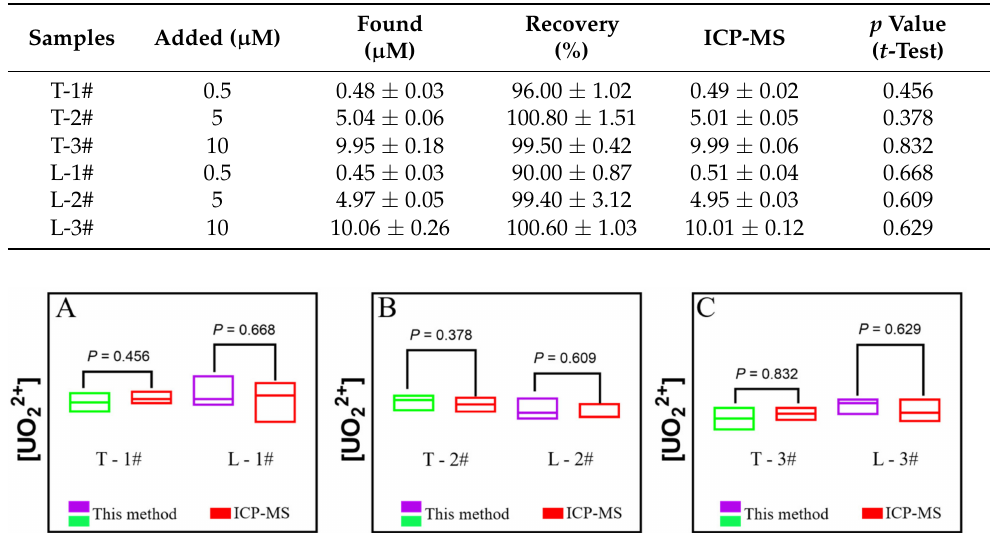
Table 1. The colorimetric analysis results for UO 2 2+ in real samples.